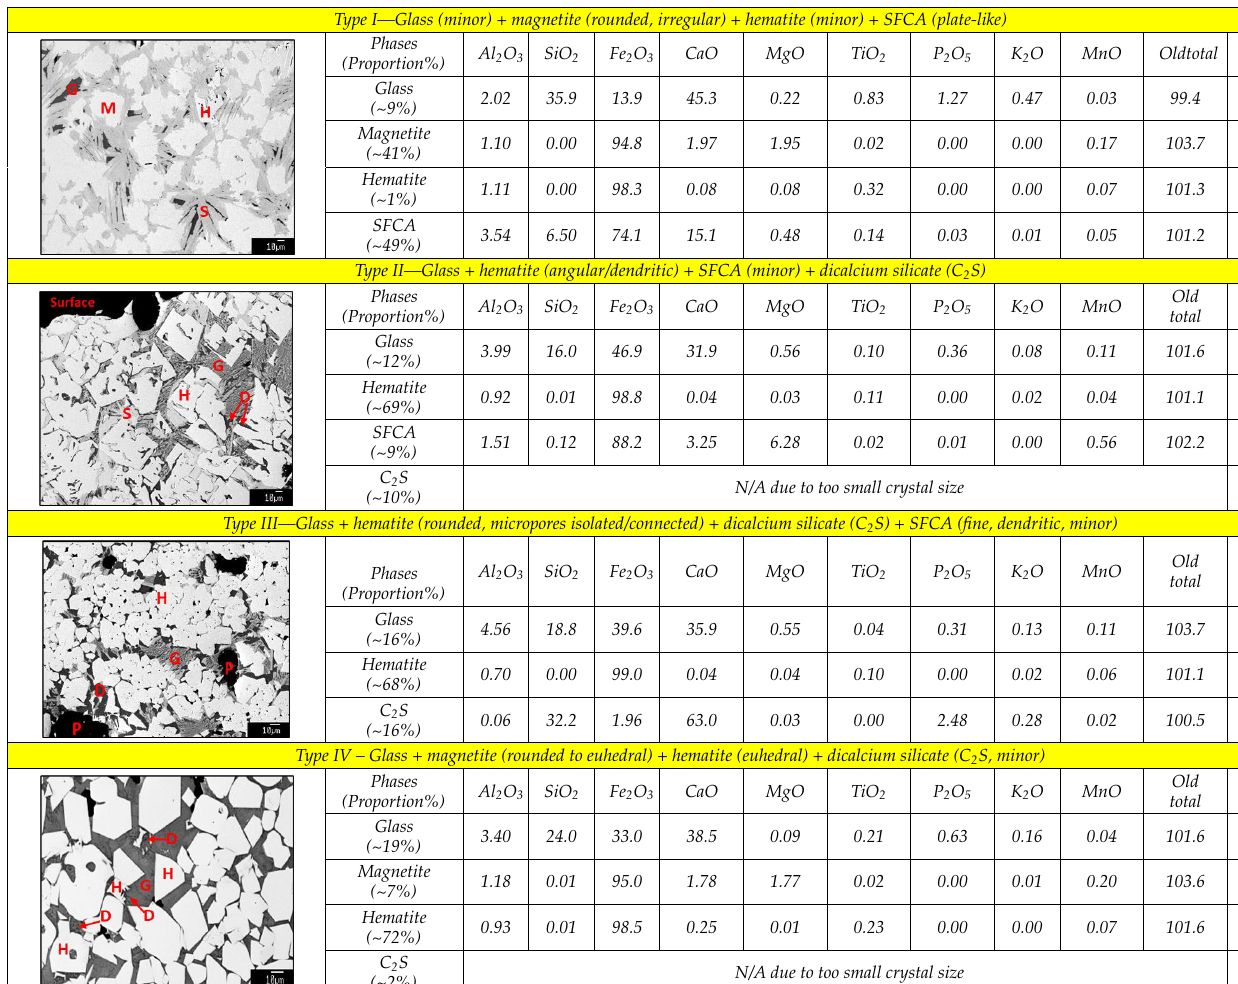
The normalised compositions of the phases present measured using EPMA and the original analytical totals of oxides (indicated as “old total”) are reported in Table 3. Vol- ume proportions of the phases estimated using Image J software 1.51k (developed by Wayne Rasband, National Institutes of Health, Bethesda, MD, USA) [28] are also included. Table 3. EPMA results of phases in microstructure types I–IV in the sample (compositions in wt% and normalised to 100% for presentation purpose only). G = Glass; H = Hematite; M = Magnetite; S = SFCA solid solution; D = Dicalcium silicate (C 2 S); P = Pores, estimated proportions (%) of the phases through image analysis are also included.